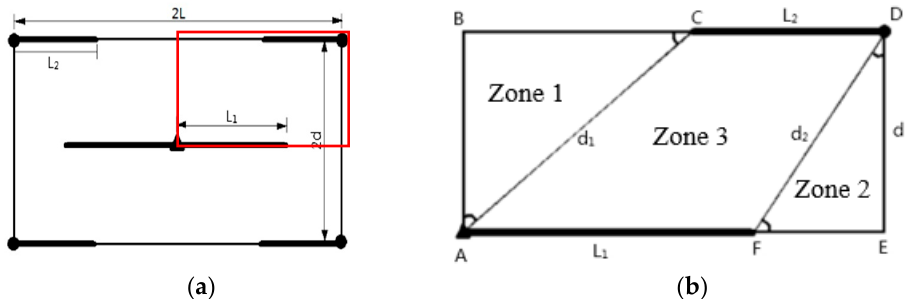
Figure 11. Rectangular well network after fracturing: ( a ) the entire well network; ( b ) the partition of a quarter of the